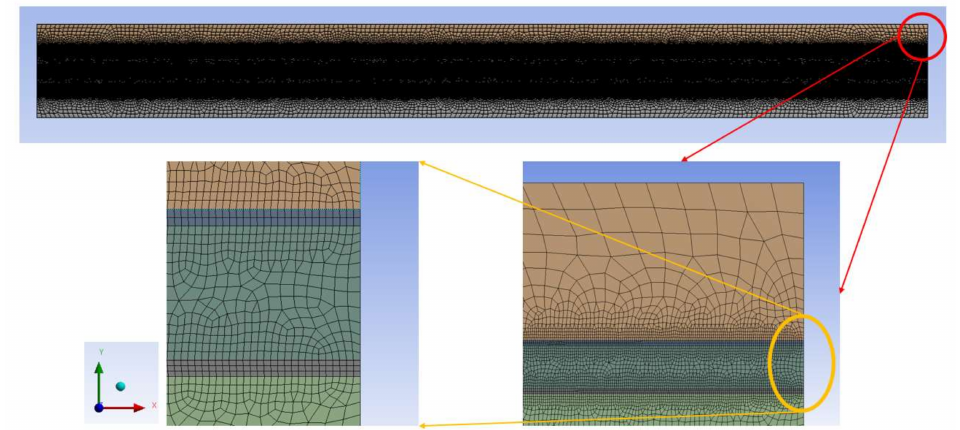
Figure 6. Meshing of 2D axisymmetric